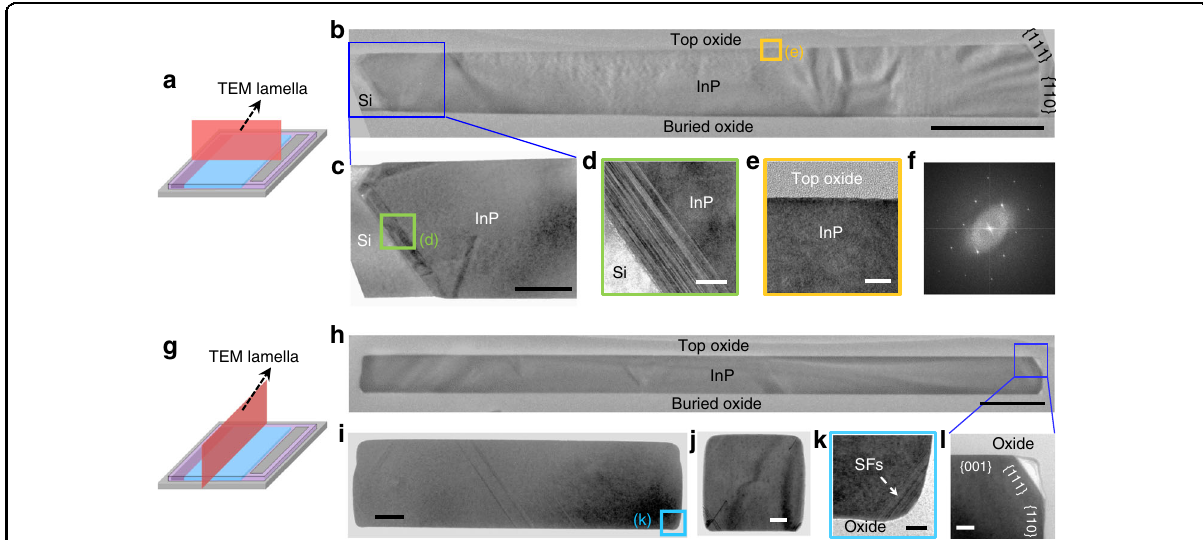
Fig. 3 TEM characterization of InP sub-micron wires and membranes. a Schematic to illustrate the TEM lamella along epitaxial direction. b Global-view TEM image of InP membrane by 10 µm pattern length. Scale bar, 1 µm. c TEM image close to Si area. Scale bar, 200 nm. d Close-up TEM image at InP/Si interface. Scale bar: 5 nm. e , f Representative TEM image at main epitaxial area and the corresponding FFT image. Scale bar, 10 nm. g Schematic to illustrate the TEM lamella perpendicular to epitaxial direction. TEM image of InP membrane ( h , i ) with 10 µm and 2 µm pattern length, and InP sub-micron wire ( j ) with 500 nm pattern length, respectively. Scale bar of h – j , 1 µm, 200 nm, and 100 nm, respectively. k Zoomed-in TEM image of i at bottom-right oxide corner. Scale bar, 20 nm. l Zoomed-in TEM image of h at upper-right corner. Scale bar, 100